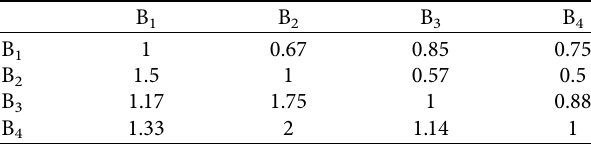
Note .B1 represents I ( z ) ,whichis the Moran’sI of SU z ;B2 represents V ( z ) , which is the VIF of SU z ; B3 represents R ( z ) , which is the R 2 of the GWR model of SU z ; B4 represents RMSE ( z ) , which is the RMSE of SU z